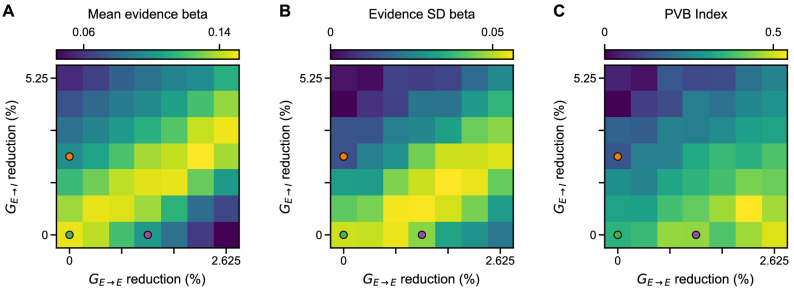
Regression analysis using evidence mean and evidence variability to predict choice, under simultaneous NMDA-R hypofunctions on excitatory and inhibitory neurons.(A) The mean evidence regression coefficient for various models of NMDA-R hypofunctions on excitatory (GE→E) and inhibitory (GE→I) neurons. (B) The evidence standard deviation regression coefficient for various models of NMDA-R hypofunctions. (C) PVB index for various models of NMDA-R hypofunctions. PVB index robustly varies with E/I perturbation. In each plot, the green, purple, and orange dots respectively denote the control, lowered E/I, and elevated E/I circuit models used in Figure 7.